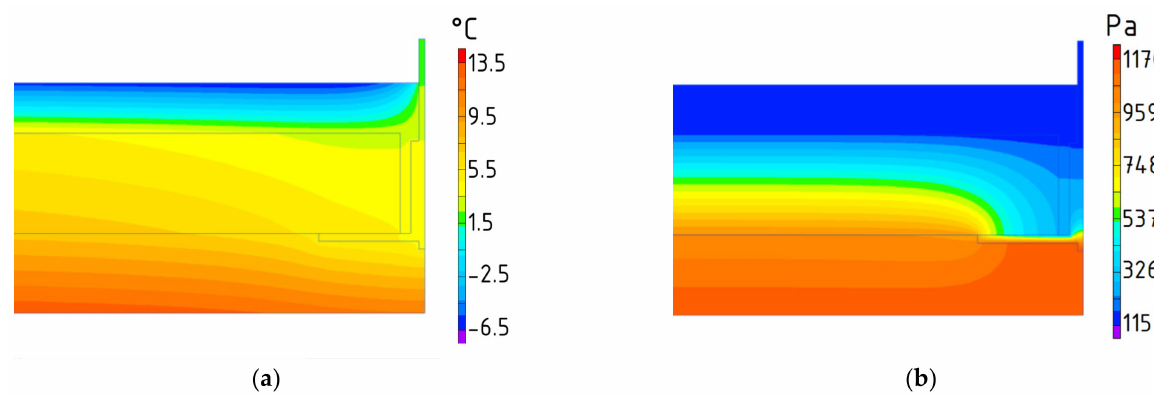
Figure 8. Calculation scheme with a gusset plate. The gaps between the angles and precast reinforced concrete elements are filled with thermal insulation (units: mm).